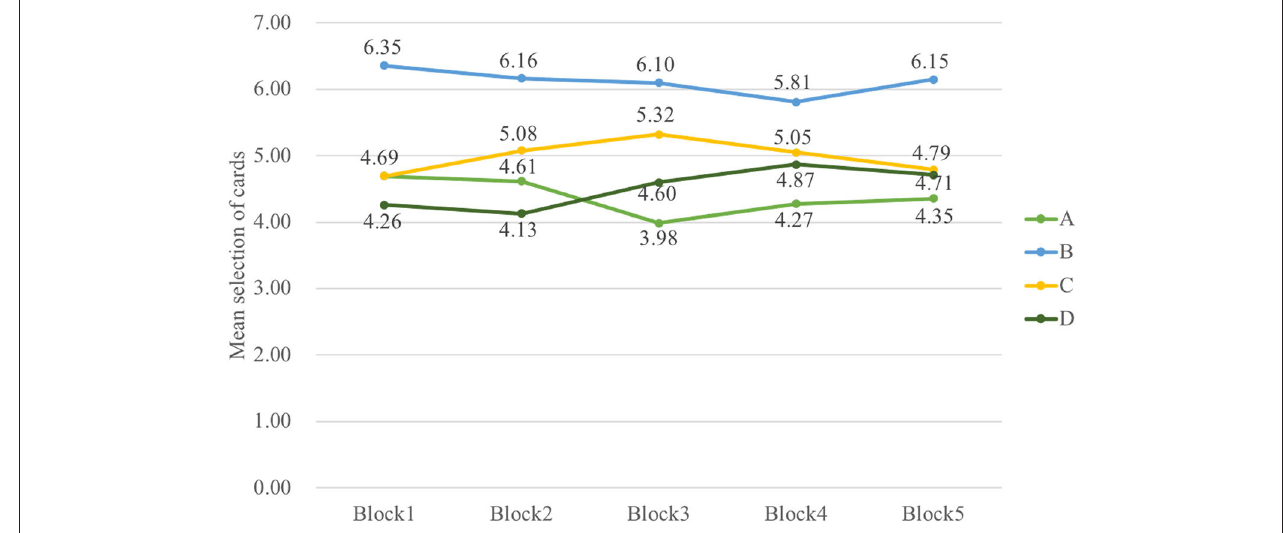
FIGURE 5 | The selective pattern of control in five blocks. No significant results are shown from the learning curve in control. The control group did not learn to choose fewer cards from disadvantageous deck B, but they tended to choose fewer cards from deck A over the last three blocks.